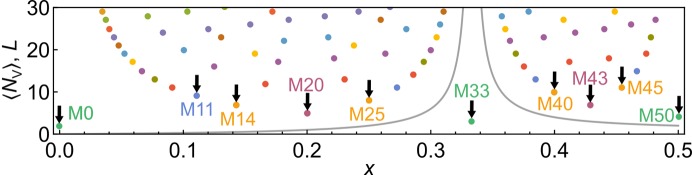
Supercell length L (coloured points) and average number of vacancies per vacancy block 〈N
V〉 (solid line) as a function of vacancy concentration x. Points with the same colour correspond to a series of rational values of α with the same numerator. For example, the bottom series of green points corresponds to α = 1/2 (M0), 1/3 (M33) and 1/4 (M50). Supercells that were used in this study are marked and labelled.